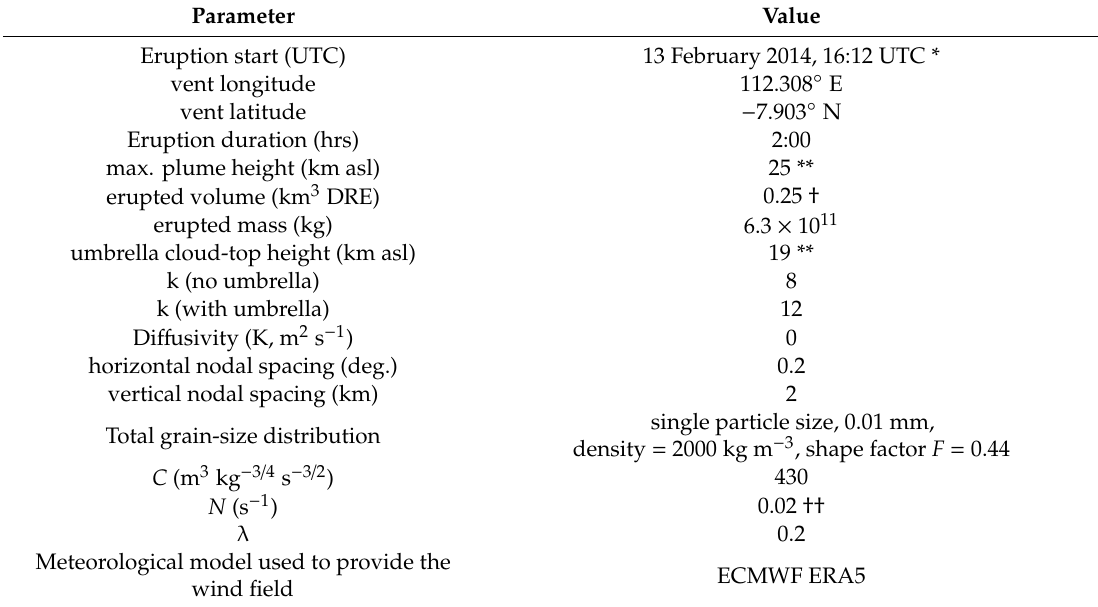
Table 2. Inputs to Ash3d simulations of